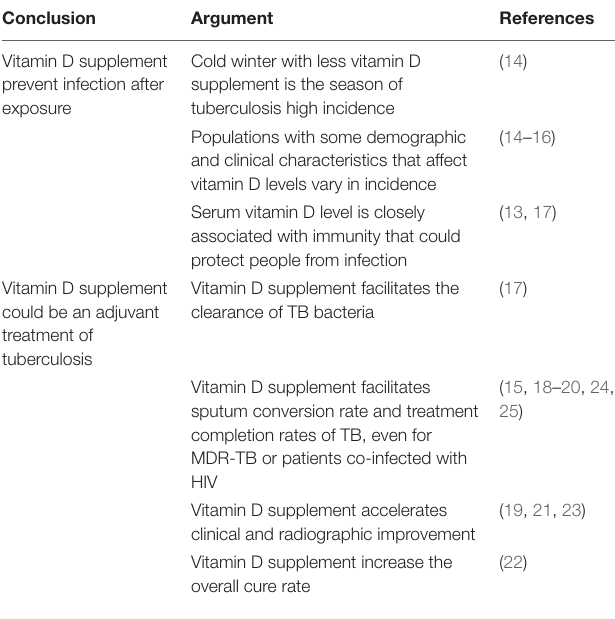
TABLE 1 | Main findings of vitamin D for tuberculosis prevention and